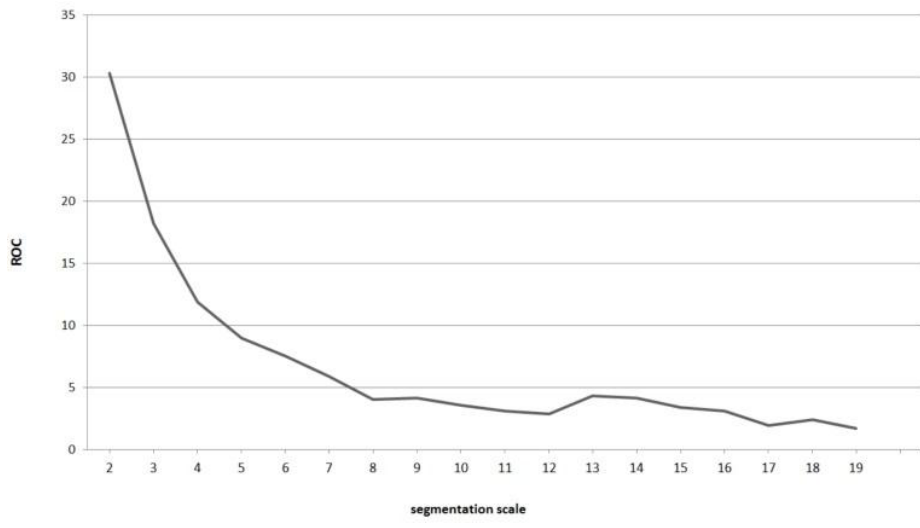
Figure 4. Estimation of Scale Parameter (ESP) results for a range of scales (1–20) for the study area.